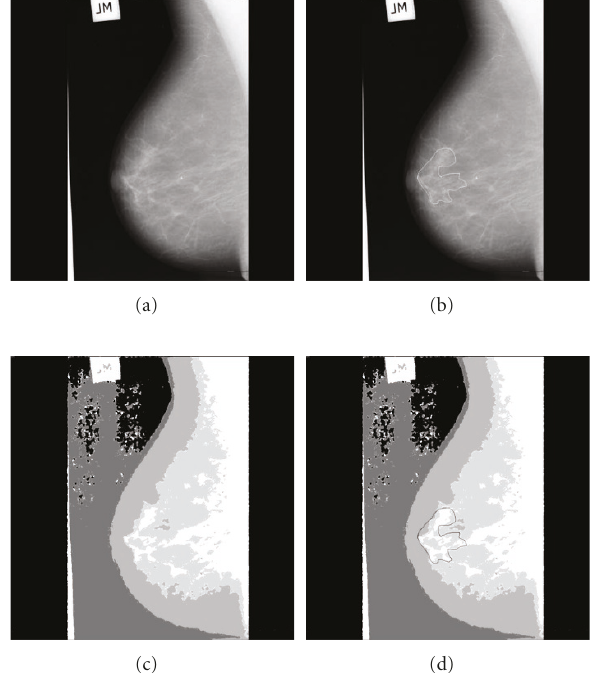
Figure 7: Segmentation results: (a) original mammogram mdb009; (b) radiologist’s manual segmentation; (c) obtained segmentation with initialization INIT A and SA algorithm (78 iterations); (d) ob- tained segmentation compared to radiologist’s manual segmenta- tion ( ρ = 0 .